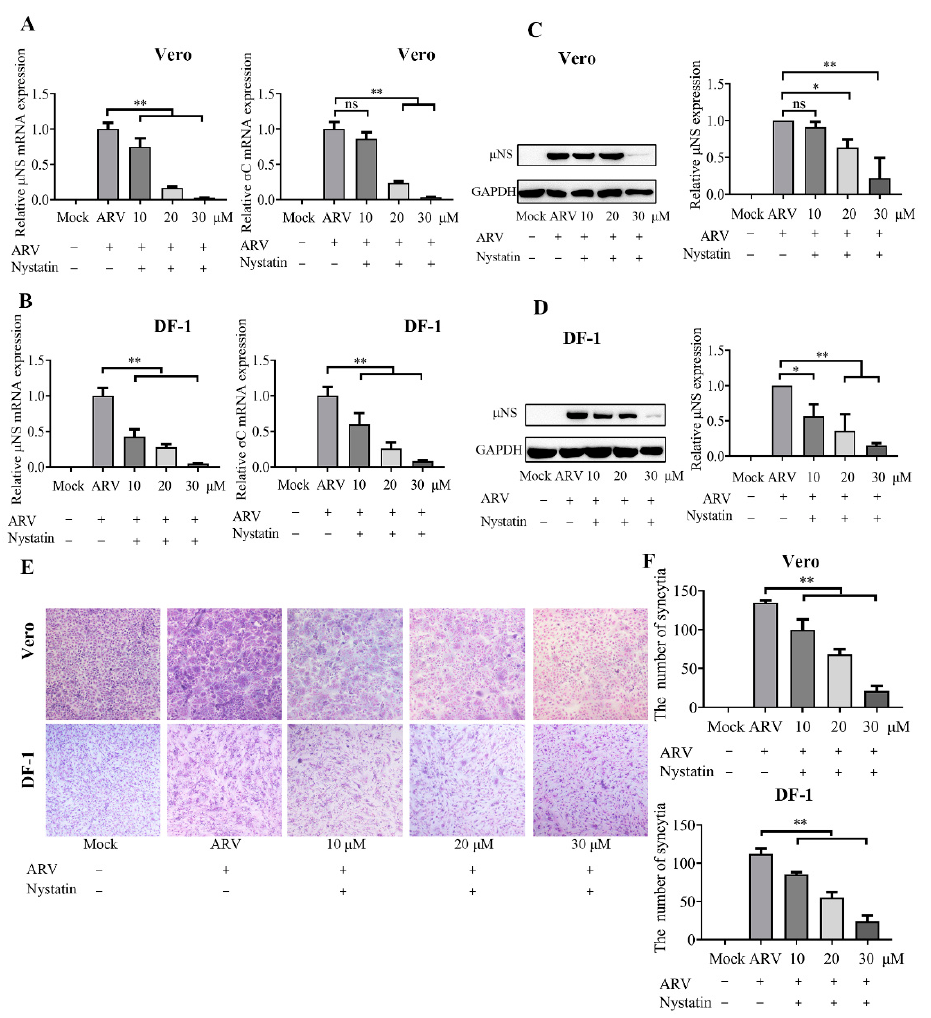
Figure 6. ARV entry is caveola dependent. Vero and DF-1 cells were pretreated with the indicated concentrations of nystatin (10, 20, 30 μ M) for 1 h and incubated with ARV (10 MOI) for 1 h at 37 °C. The bound but unpenetrated virions were inactivated with citrate buffer. ( A ) The mRNA expression levels of the ARV- μ NS and σ C genes in Vero cells were determined by qRT-PCR at 9 hpi. ( B ) The mRNA expression levels of the ARV- μ NS and σ C genes in DF-1 cells were determined by qRT-PCR at 9 hpi. ( C , D ) The level of ARV μ NS protein in Vero ( C ) and DF-1 ( D ) cells was analyzed by Western blotting at 9 hpi. ImageJ software was used to analyze the relative levels of μ NS protein in comparison with ARV group that without drug treatment, and the ratios from three independent experiments are displayed as fold changes in the histograms. ( E ) The level of syncytium formation in Vero and DF-1 cells was detected by Giemsa-staining at 12 hpi. Images were captured on an inverted microscope at 10× objective. ( F ) The number of syncytia per microscopic field in Vero and DF-1 cells. Results are presented as the means ± SD of data from three independent experiments. *, p < 0.05; **, p < 0.01.